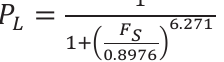
Figure 4: Bayesian mapping function along the case history databaseusing the corrected version of the simplified procedure. CSR = cyclic stress